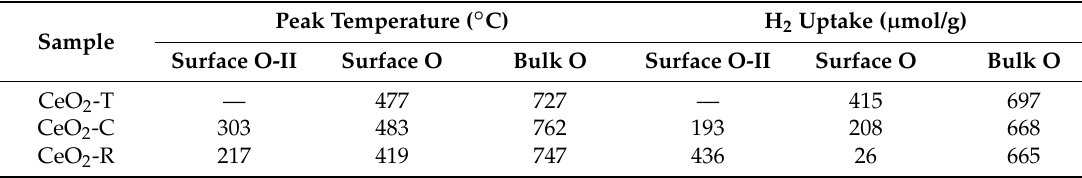
Figure 5. H 2 -TPR curves of CeO 2 with different morphologies. Table 2. H 2 -TPR results of CeO 2 with different morphologies.